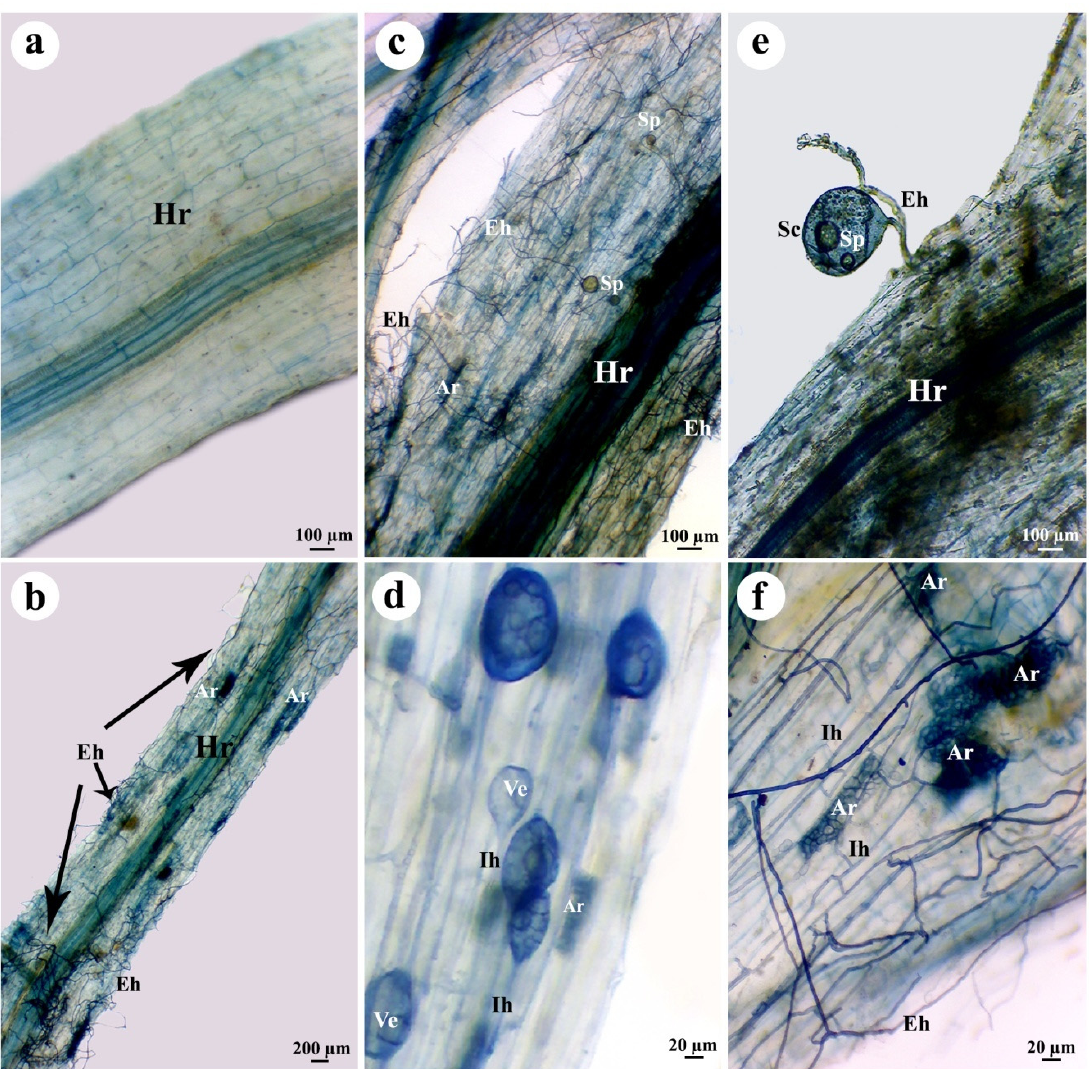
Figure 7. Light micrographs of sunflower roots colonized with R. irregularis displaying typical mycorrhizal structures (at 28 dpi), control plant ( a ), and R. irregularis -colonized plant ( b – f ), where, Hr = host root, Ih = interaradical hyphae, Eh = exteraradical hyphae, Sp = spore, Sc = sporocarp, Ve = vesicle, and Ar = arbuscule.